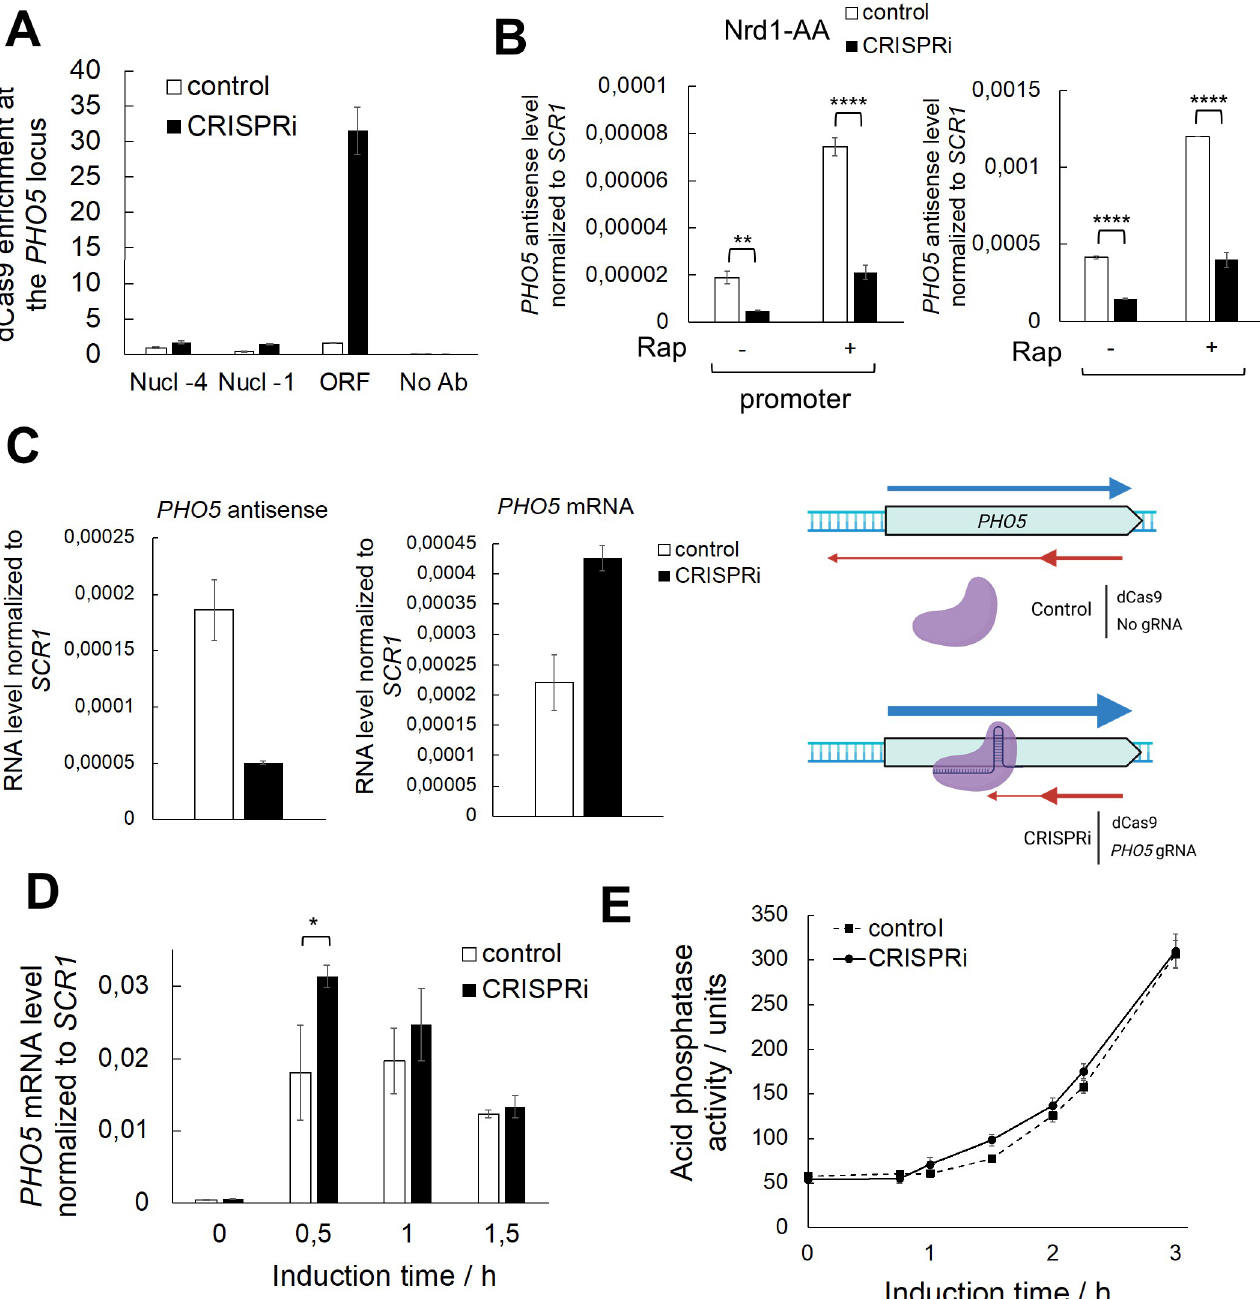
Fig 5. Targeting dCas9 to specifically block PHO5 AS transcription enhances expression kinetics of the PHO5 gene. (A) Chromatin immunoprecipitation (ChIP) analysis of dCas9 binding at the PHO5 gene locus. Immunoprecipitated DNA was quantified by qPCR with primers specific for different regions of the PHO5 promoter (Nucleosomes -4 and -1) and ORF regions. Both strains were transformed with a dCas9 expressing plasmid, while the CRISPRi strain was additionaly transformed with a plasmid expressing a gRNA targeted to strand-specifically block PHO5 AS transcription and the control strain with the corresponding empty plasmid. Nucl—nucleosome, No Ab—no antibody ChIP control. (B) Levels of PHO5 AS transcribed at the PHO5 promoter and ORF regions at 0 h of induction in Nrd1-AA strain with or without addition of rapamycin (for 1 hour; to deplete Nrd1 and induce AS transcription) and an active CRISPRi system. RT-qPCR values were normalized to SCR1 RNA. Reported values represent the means and standard deviations of three independent experiments (n = 3). Indicated differences show the significant differences using an unpaired Student’s t test. Two ( �� ) and four ( ���� ) asterisks denote a p-value lower than or equal to 0.01 and 0.0001, respectively. (C) Levels of PHO5 AS and mRNA transcripts in the CRISPRi and the corresponding control strain, monitored by RT-qPCR at 0 h of induction as in (B). Strains are Nrd1-AA with the absence of rapamycin (wild-type equivalent). Right: Scheme of the CRISPRi strategy used to block PHO5 AS transcription. Strains were transformed with two plasmids, one expressing dCas9, and the other expressing or not a gRNA